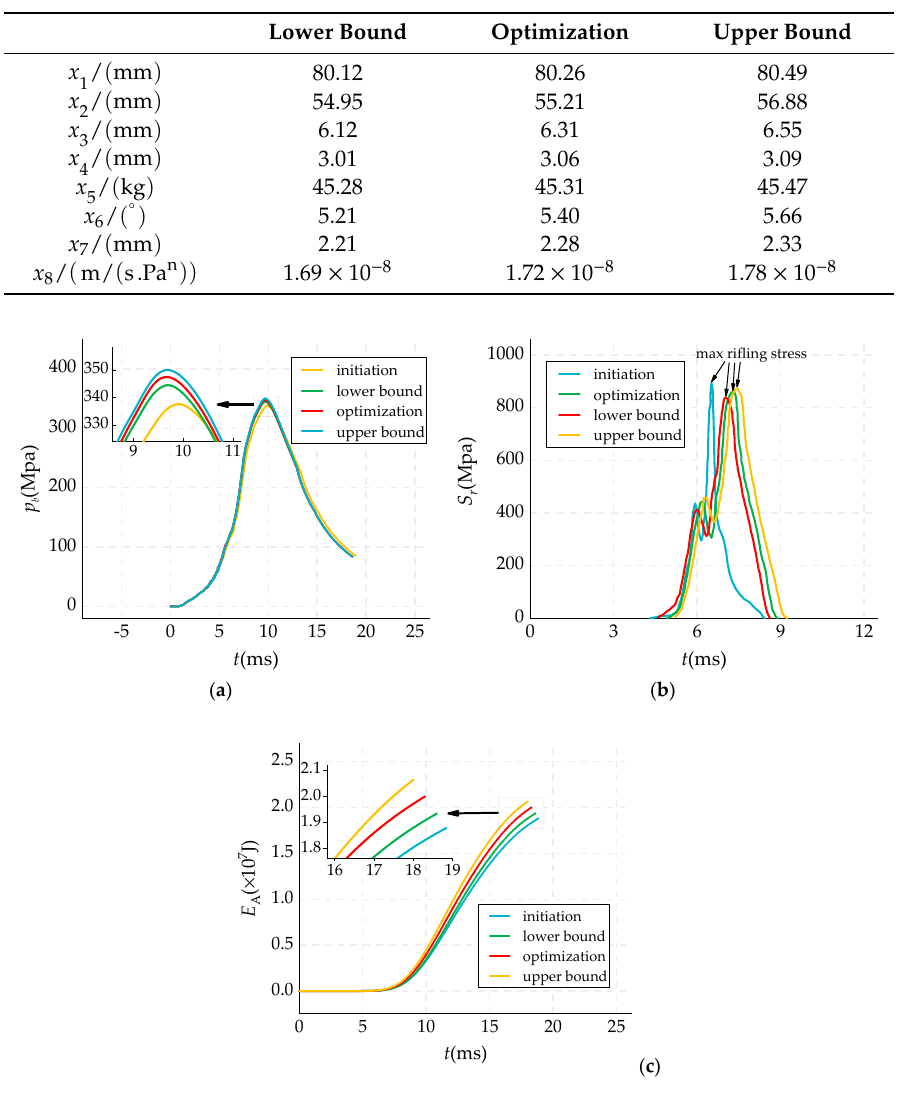
Table 6. The optimized intervals of design variables.